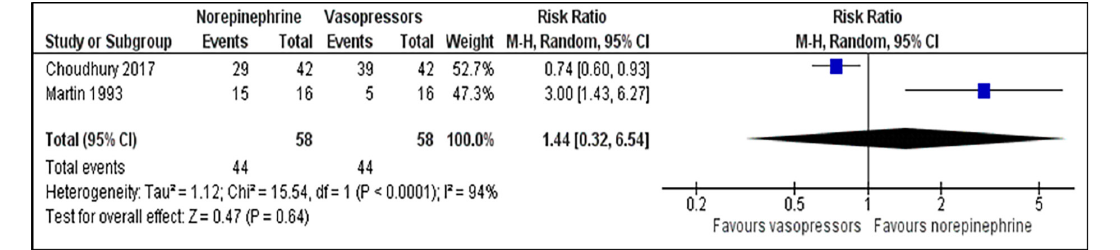
Figure 2. Comparison between norepinephrine and vasopressors for the outcome of the number of participants who achieved the target mean arterial pressure. M-H, Mantel-Haenszel method; CI, confidence interval.